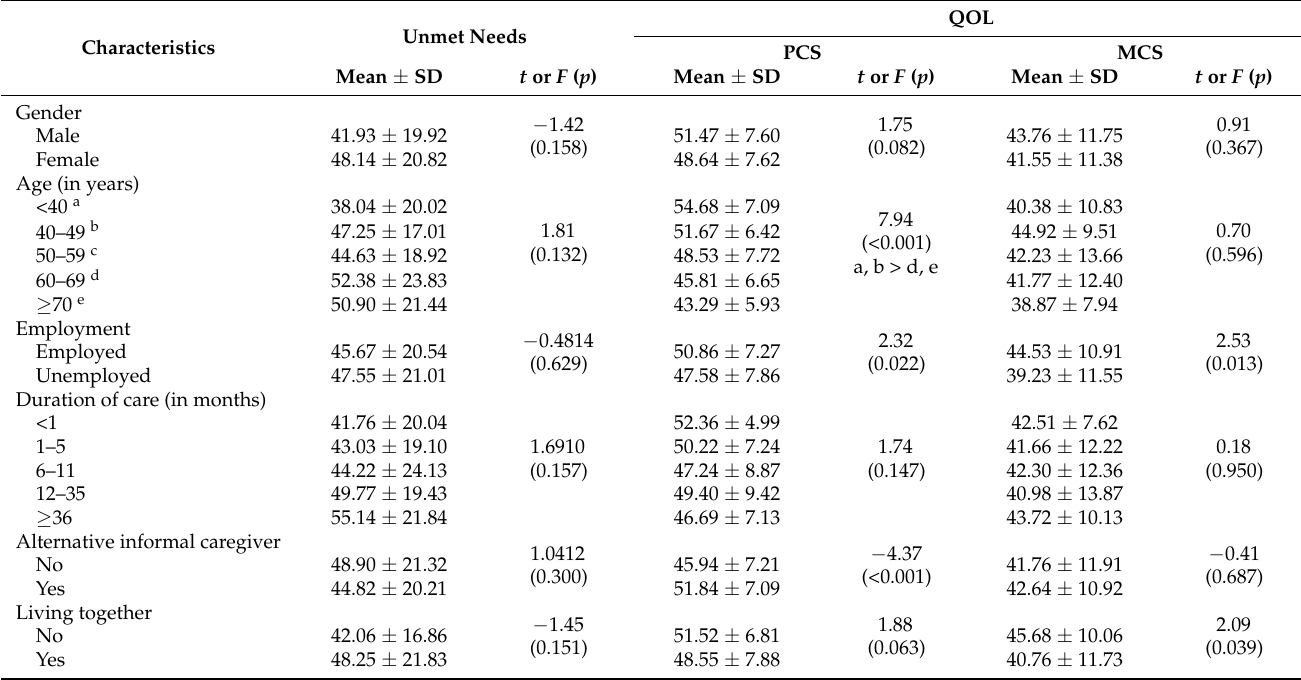
Table 4. Differences in measured variables on the general and disease-related characteristics (Family).